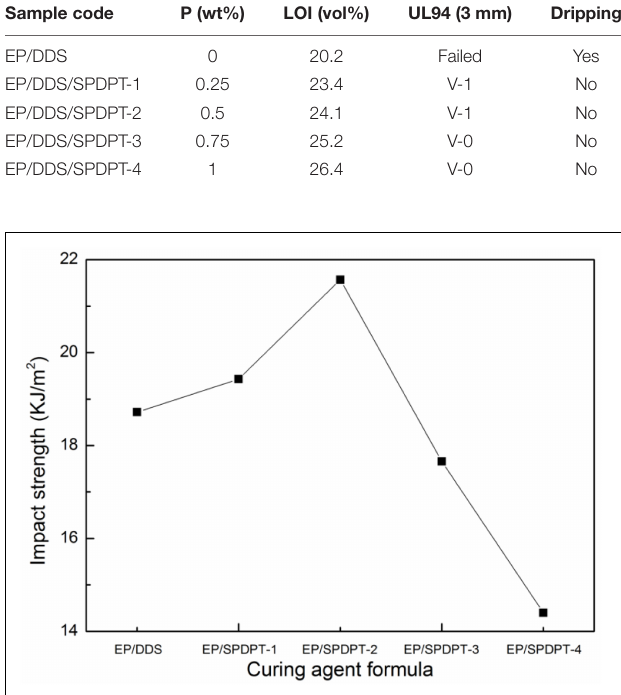
FIGURE 10 | Impact properties of epoxy